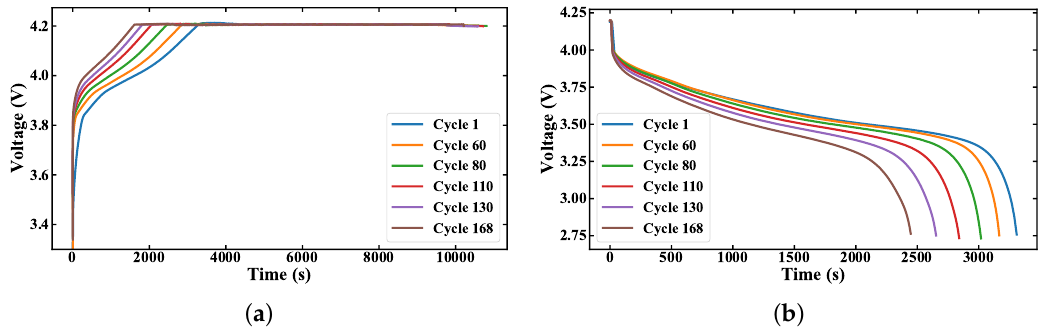
Figure 3. ( a ) Charge curves of Battery #6 at different cycle numbers. ( b ) Discharge curves of Battery #6 at different cycle